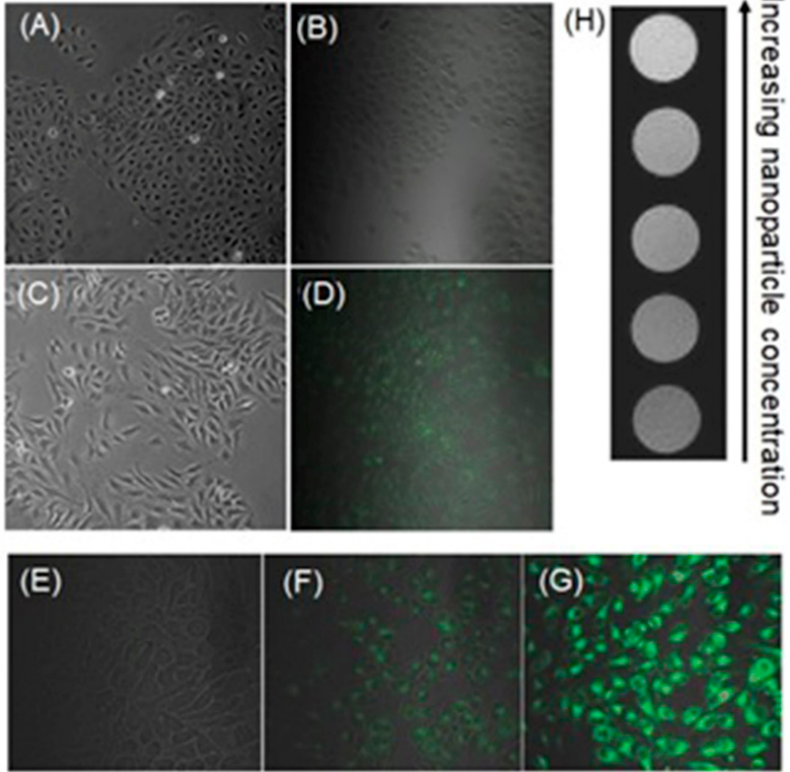
Figure 28. ( A ) Optical microscopy image and ( B ) fluorescence microscopy image of HaCaT cells. ( C ) Optical microscopy image and ( D ) fluorescence microscopy image of HeLa cells incubated with the nanoprobe. More green fluorescence was observed in HeLa cells compared to HaCaT cells, indicating greater accumulation and dissolution of the nanoprobe in acidic hypoxic cells. ( E – G ) Fluorescence microscopy images of HeLa cells treated with a MnO-based nanoprobe at 3, 12, and 24 h, respectively. Increase in fluorescence intensity was observed due to target-specific accumulation and dissolution of nanoprobe in hypoxic HeLa cells. (H) T 1 -weighted MRI images of HeLa cells incubated with the different nanoparticle concentrations (0–300 μ g mL –1 ) for 24 h. Concentration-dependent MRI signal enhancement was observed as indicated by enhancement in in T 1 -weighted contrast of the samples containing HeLa cells. Adapted with permission from Hsu, B. Y. W.; Ng, M.;